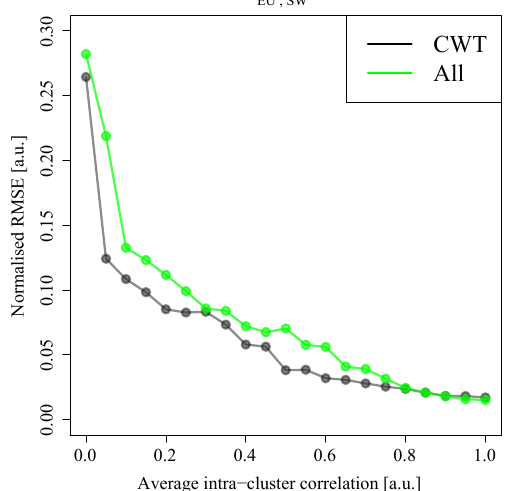
Figure 6. As Fig. 5 but for the RMSE normalised to the average generation.